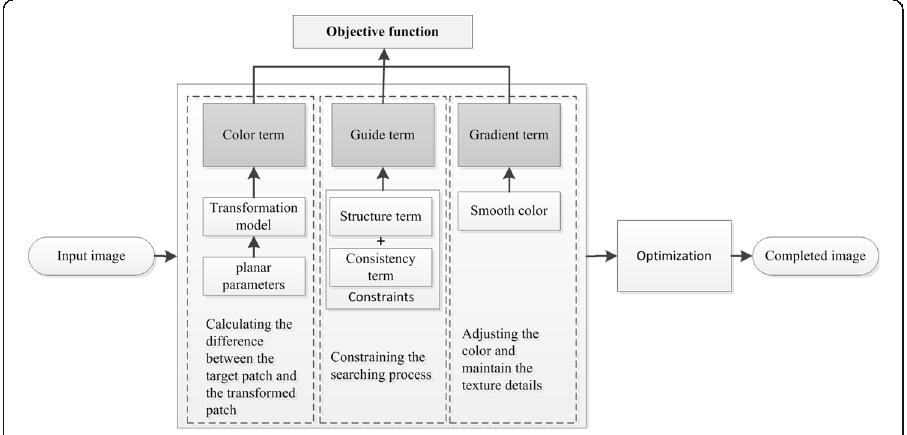
Fig. 1 Flowchart of proposed